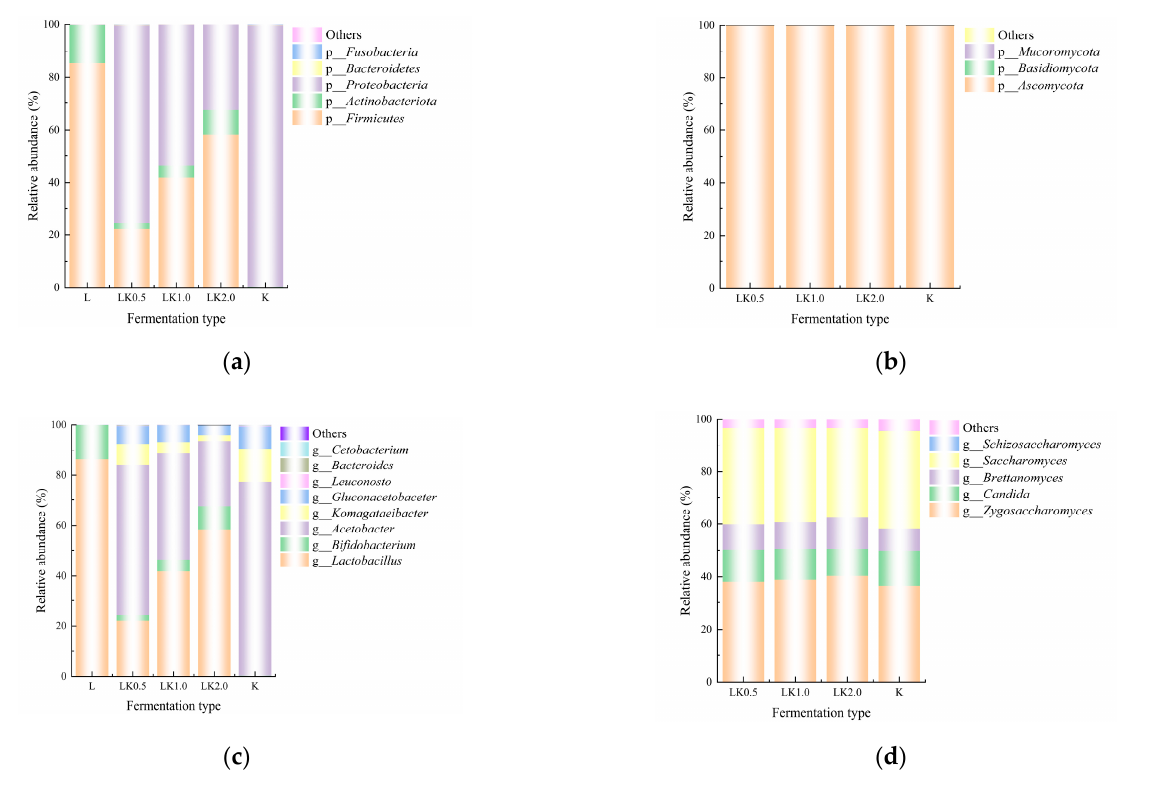
Figure 3. Relative abundance at the ( a ) bacterial phylum, ( b ) fungal phylum, ( c ) bacterial genus, and ( d ) fungal genus levels.